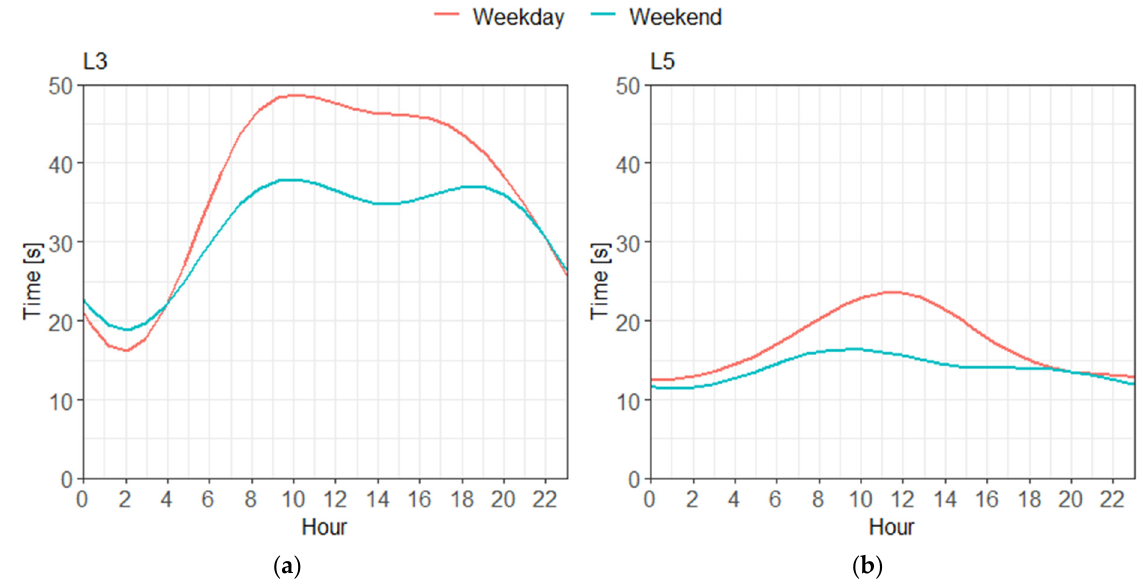
Figure 7. The mean transit time values for individual hours of the day at locations: ( a ) L3, and ( b ) L5. Figure generated using the ggplot2 package [43].